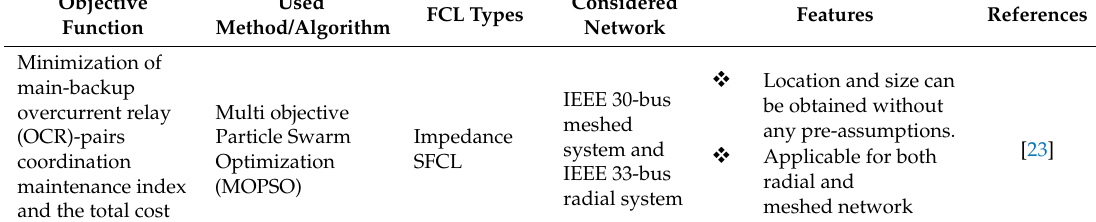
Table 4. Optimization techniques for the placement of superconducting FCLs.